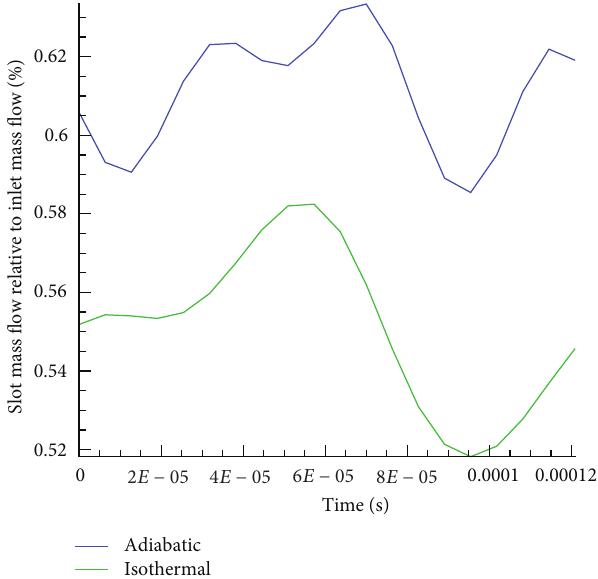
F 15: Time history of the slot mass �ow percentage relative to the inlet mass �ow.